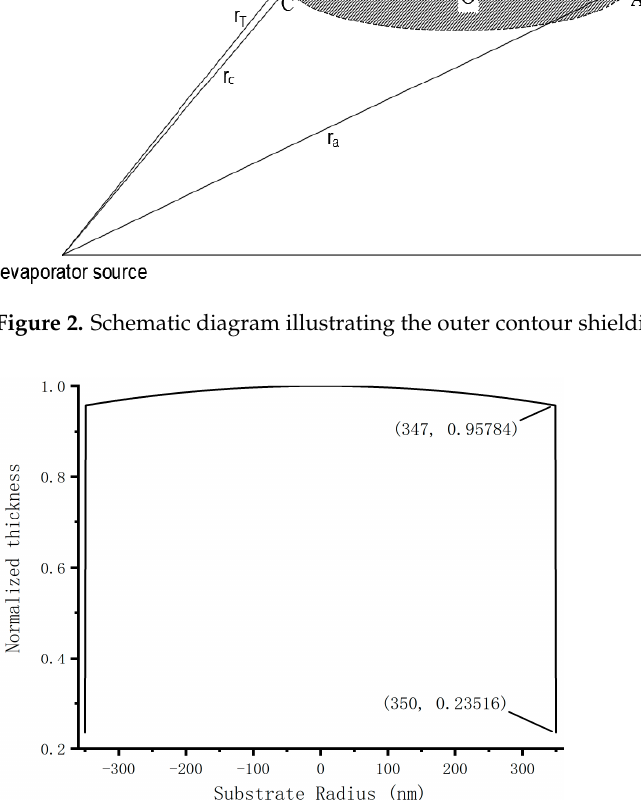
Figure 3. Normalized thickness distribution for the counter planet undergoing 37 revolutions of the planetary rotation.